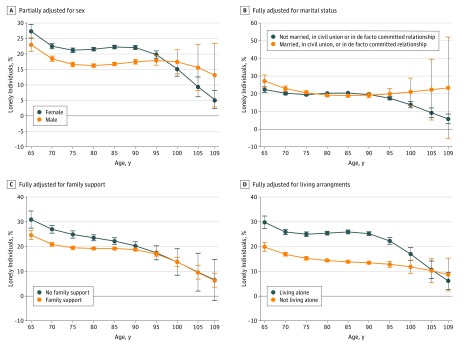
Modification of the Association Between Loneliness and AgeError bars indicate 95% CIs.